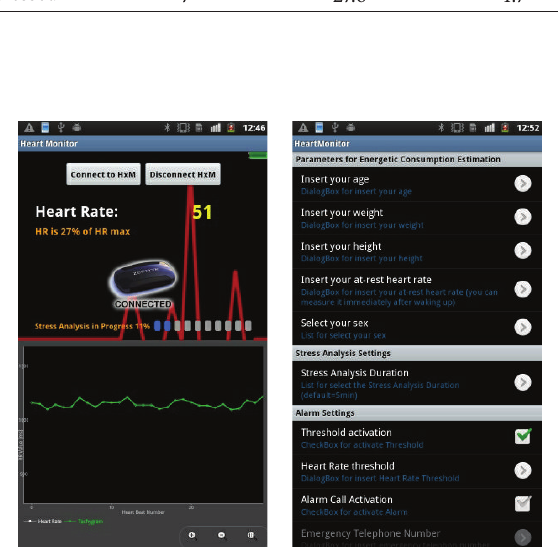
Figure 8: Application interfaces: main interface and settings inter- face.